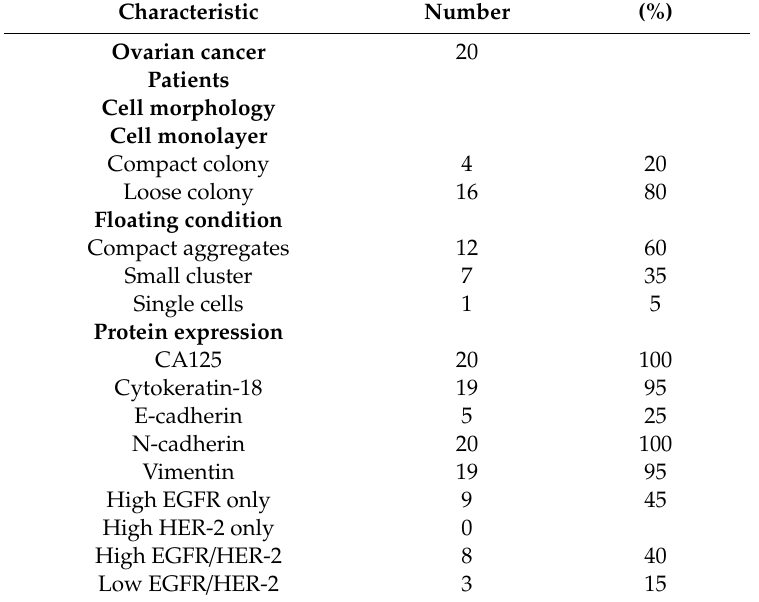
Table 2. Summary of characteristics of ascitic fluid-derived cells that are cultured in in vitro condition and selective protein markers for epithelial cells.